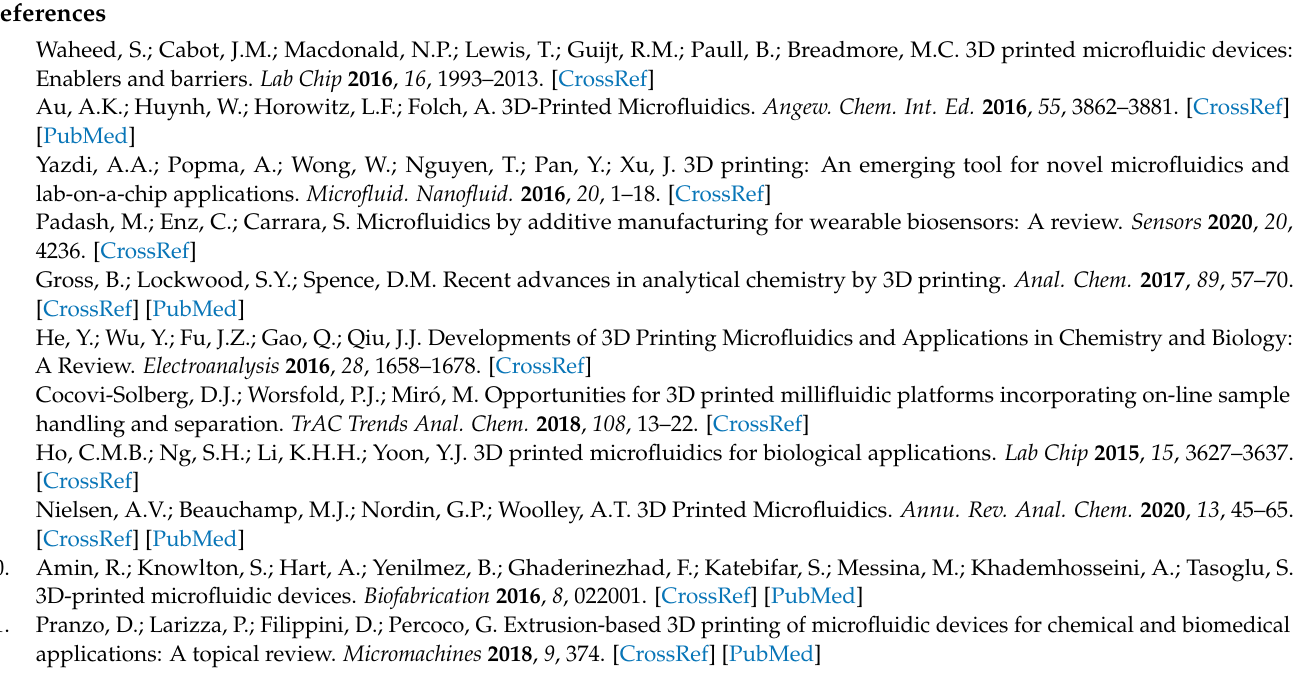
Table S2: Catalog of papers used in the review, https://www.mdpi.com/2072-666X/12/3/339/s3, Tables S3–5: 3D printers and